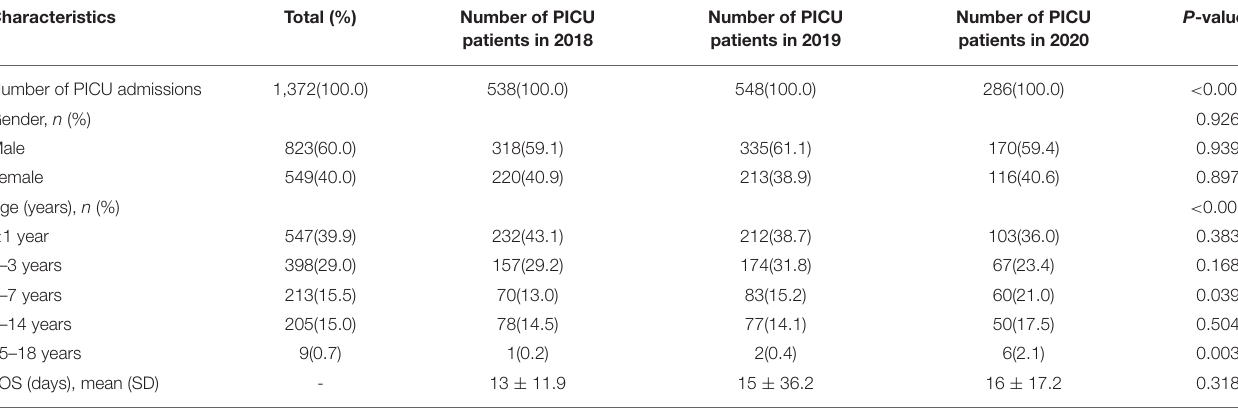
TABLE 1 | Characteristics of the patients admitted to the pediatric intensive care unit by year (2018–2020).